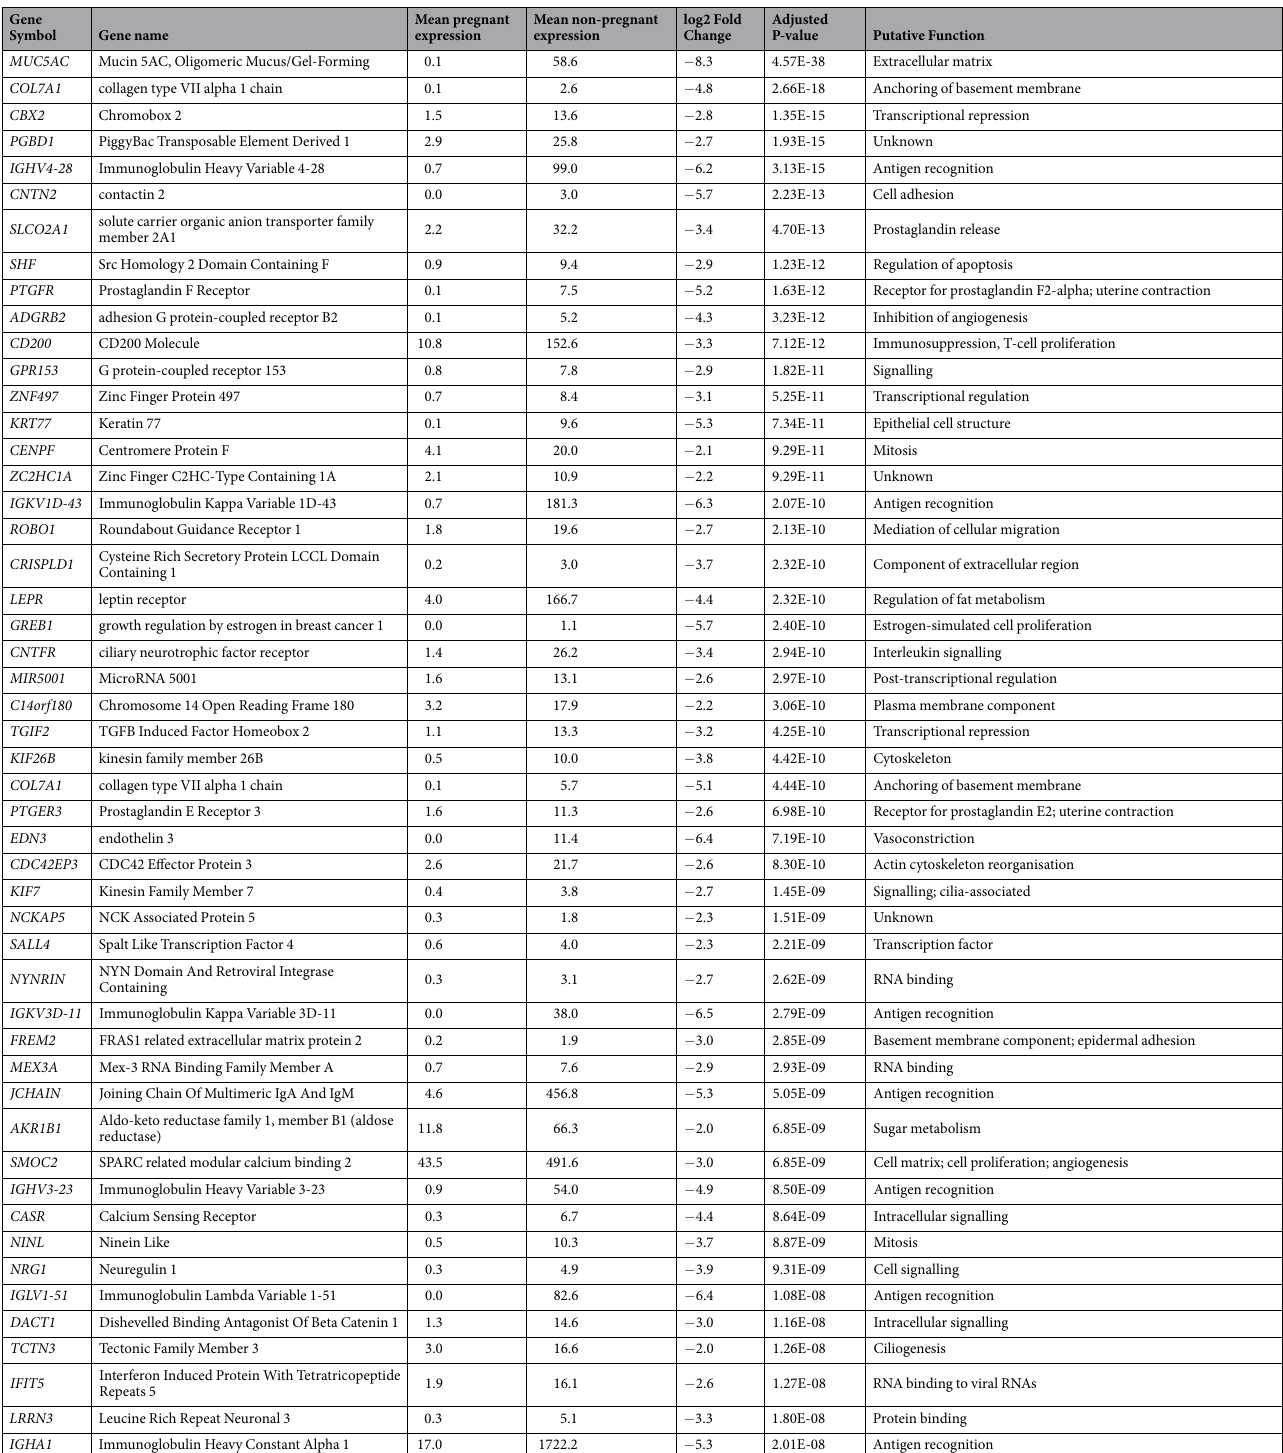
Table 2. The top 50 significantly down-regulated annotated genes during pregnancy, ranked by adjusted P-value, displaying best BLAST hit HUGO Gene Symbol, log2 ratios, and FDR‐adjusted p‐values, along with mean expression values per stage. Mean expression values are normalized transcripts per million